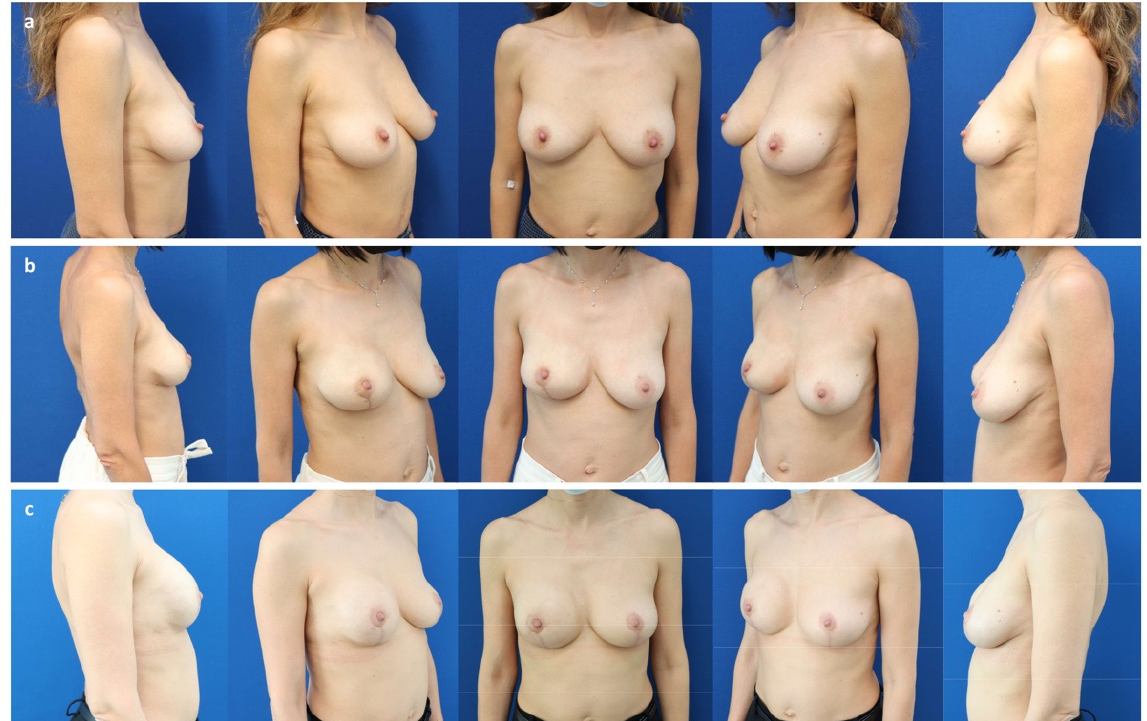
Figure 4. ( a ) A 43-year-old patient with multifocal invasive-ductal carcinoma (pT1c pN1mi M0) of the right breast. ( b ) Six months after a nipple sparing mastectomy through a lateral hemi-areolar access with vertical extension and prepectoral expander placement (Motiva Flora ® XMF-58 440 cc) and ADM (SurgiMend ® PRS meshed, Integra LifeSciences, Princeton NJ, USA) use. ( c ) One year after expander exchange for a definitive implant (Motiva Ergonomix ® ERSD 300 cc) and autologous fat grafting to the mastectomy flap (140 cc) and mastopexy of the left breast (“auto-augmentation”).